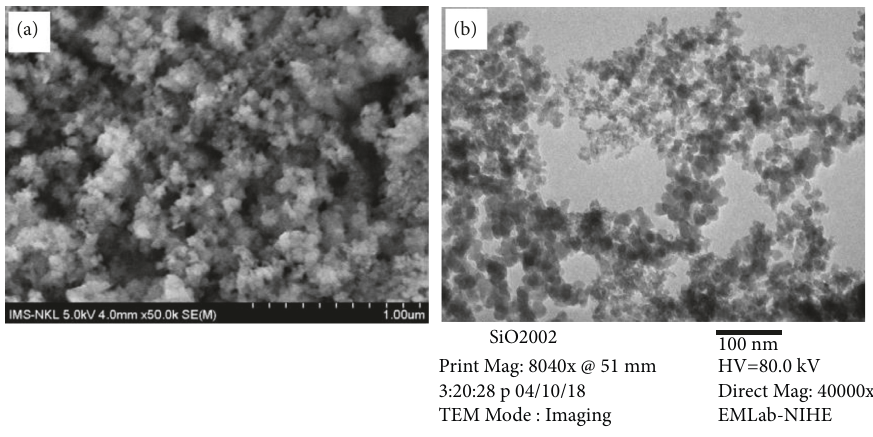
Figure 1: FE-SEM (a) and TEM (b) images of SiO